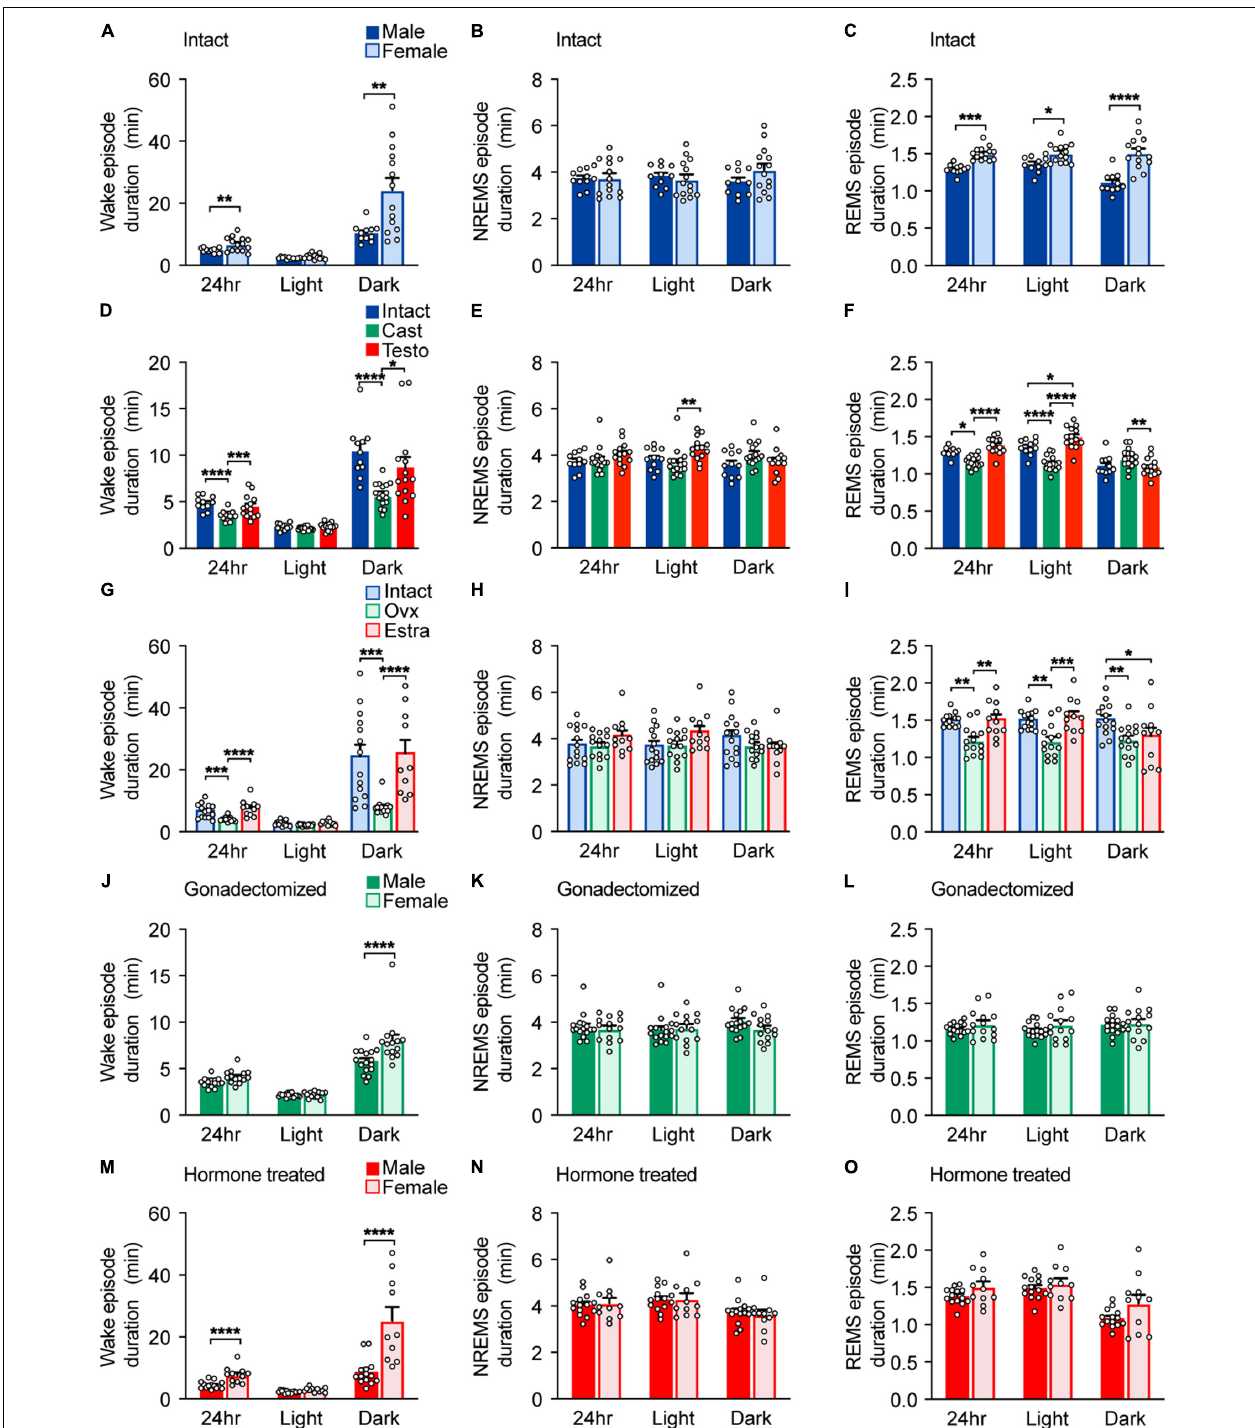
FIGURE 2 | Episode durations of intact, gonadectomized, and hormone-supplemented mice. (A–C) Episode durations of wakefulness (A) , NREMS (B) , and REMS (C) of intact male and female mice; 11 male mice and 14 female mice. Two-way ANOVA followed by Sidak’s test or Mann–Whitney U test). (D–F) Episode durations of wakefulness (D) , NREMS (E) , and REMS (F) of male mice. Two-way ANOVA followed by Sidak’s test or Kruskal–Wallis test. (G–I) Episode durations of wakefulness (G) , NREMS (H) , and REMS (I) of female mice. Two-way ANOVA followed by Sidak’s test or Kruskal–Wallis test. (J–L) Episode durations of wakefulness (J) , NREMS (K) , and REMS (L) of gonadectomized male and female mice; 16 male mice and 14 female mice. Two-way ANOVA followed by Sidak’s test. (M–O) Episode durations of wakefulness (M) , NREMS (N) , and REMS (O) of gonadal hormone-supplemented gonadectomized male and female mice; 14 male mice and 11 female mice. Two-way ANOVA followed by Sidak’s test or Mann–Whitney U test. * P < 0.05; ** P < 0.01; *** P < 0.001, **** P <